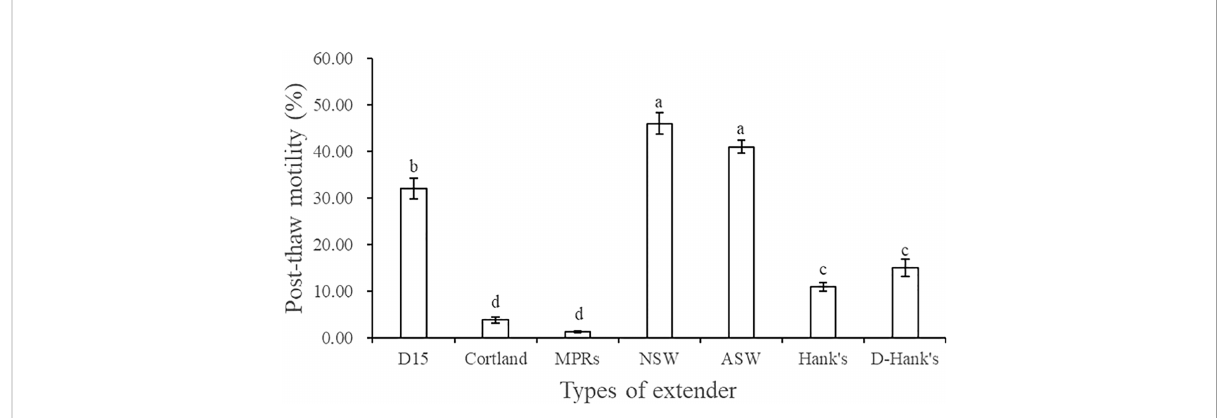
FIGURE 1 Effect of extender type on the post-thaw motility of A. japonicus spermatozoa. Data are presented as means ± SE (n = 6). Different letters indicate signi fi cant differences (P < 0.05). Data were not transformed when performing one-way